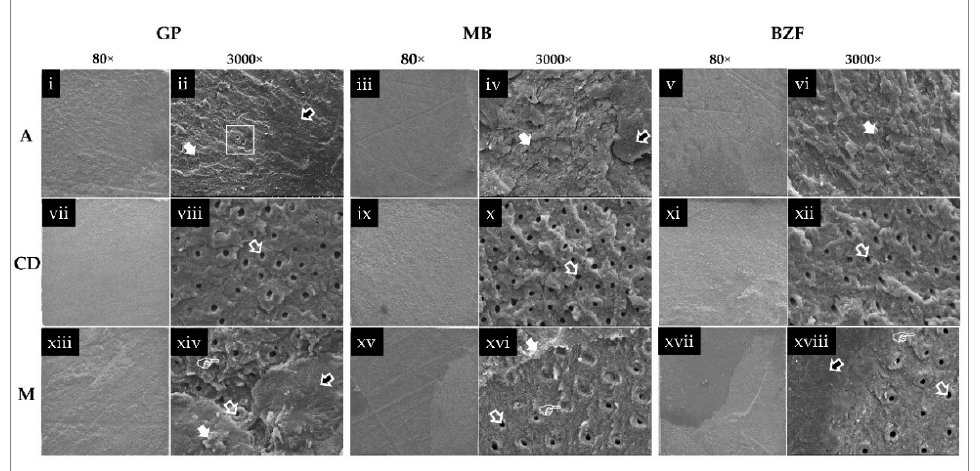
Figure 3. Representative SEM images of the adhesives’ (GP—G ‐ Premio Bond; MB—Clearfil Mega ‐ bond 2; BZF—BZF 29) fracture modes. The images under 3000× columns demonstrate the magni ‐ fied specific features of the preceding 80× images. Row A is adhesive failure, row CD is cohesive failure in dentin, and row M is the mixed type of failure involving adhesive and dentin. The white arrows indicate a cohesive failure in the adhesive ( ii , iv , vi ); the white rectangle includes bubbles ( ii ); white ‐ bordered black arrows show darker adhesive areas indicating failure at the composite resin ‐ adhesive interface ( ii,iv,xiv,xviii ); transparent white arrows indicate the dentinal tubules’ openings ( viii,x,xii,xiv,xvi,xviii ). The mixed failure patterns ( xiv,xvi,xviii ) also show complete or partially occluded dentinal tubules (white hands).